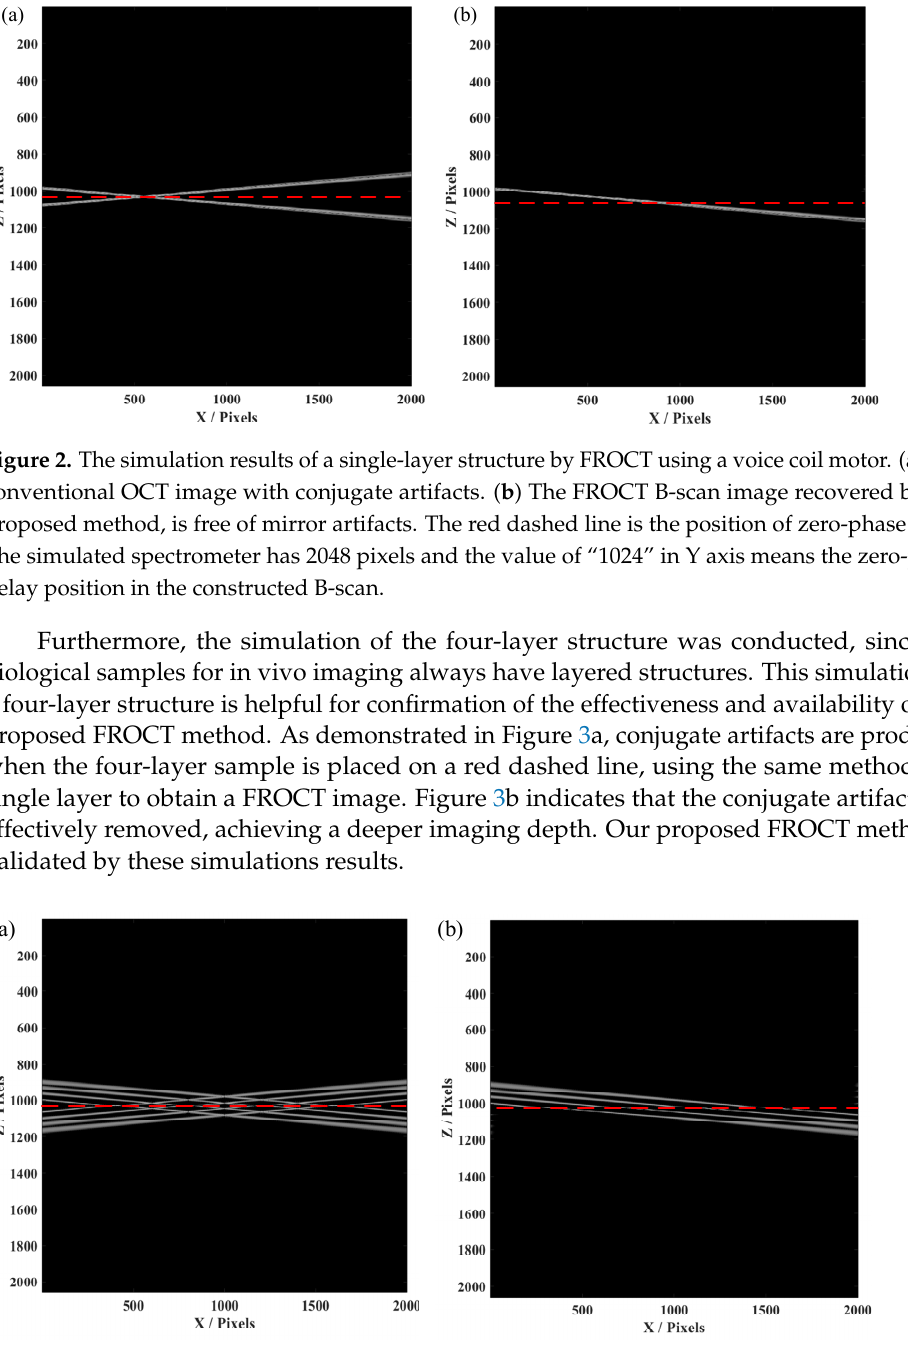
Figure 3. The simulation results of four-layer structure FROCT using a voice coil motor. ( a ) The conventional OCT image. ( b ) The FROCT B-scan recovered image.